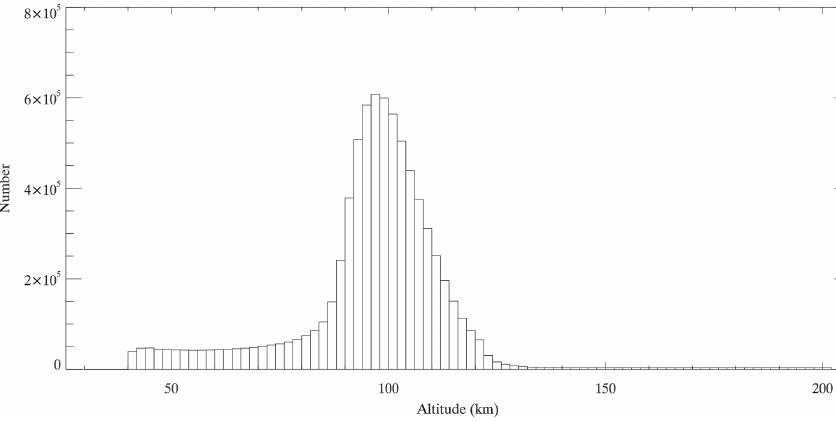
Figure 1. The altitude distribution of COSMIC S4max profiles from December 2006 to January 2014.